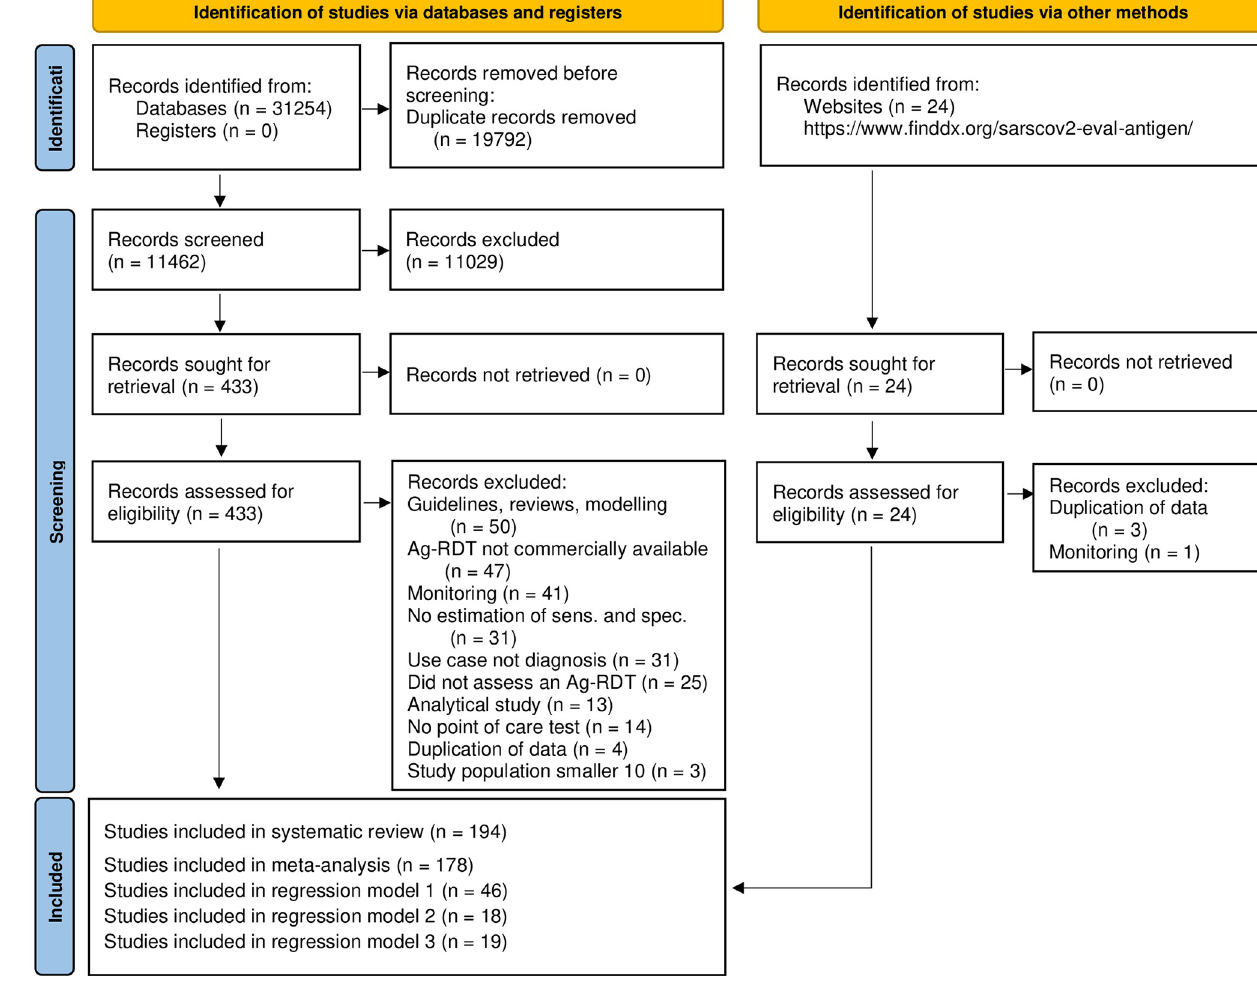
Fig 1. PRISMA flow diagram. AU : AbbreviationlisthavebeencompiledforthoseusedinFigs 1 ; 3 (cid:0) 5 ; S 1 ; andS 3 (cid:0) S 11 : Pleaseverifythatallentriesarecorrect : Based on Page and colleagues [214]. Ag-RDT, antigen rapid diagnostic tests; IFU, instructions for use.